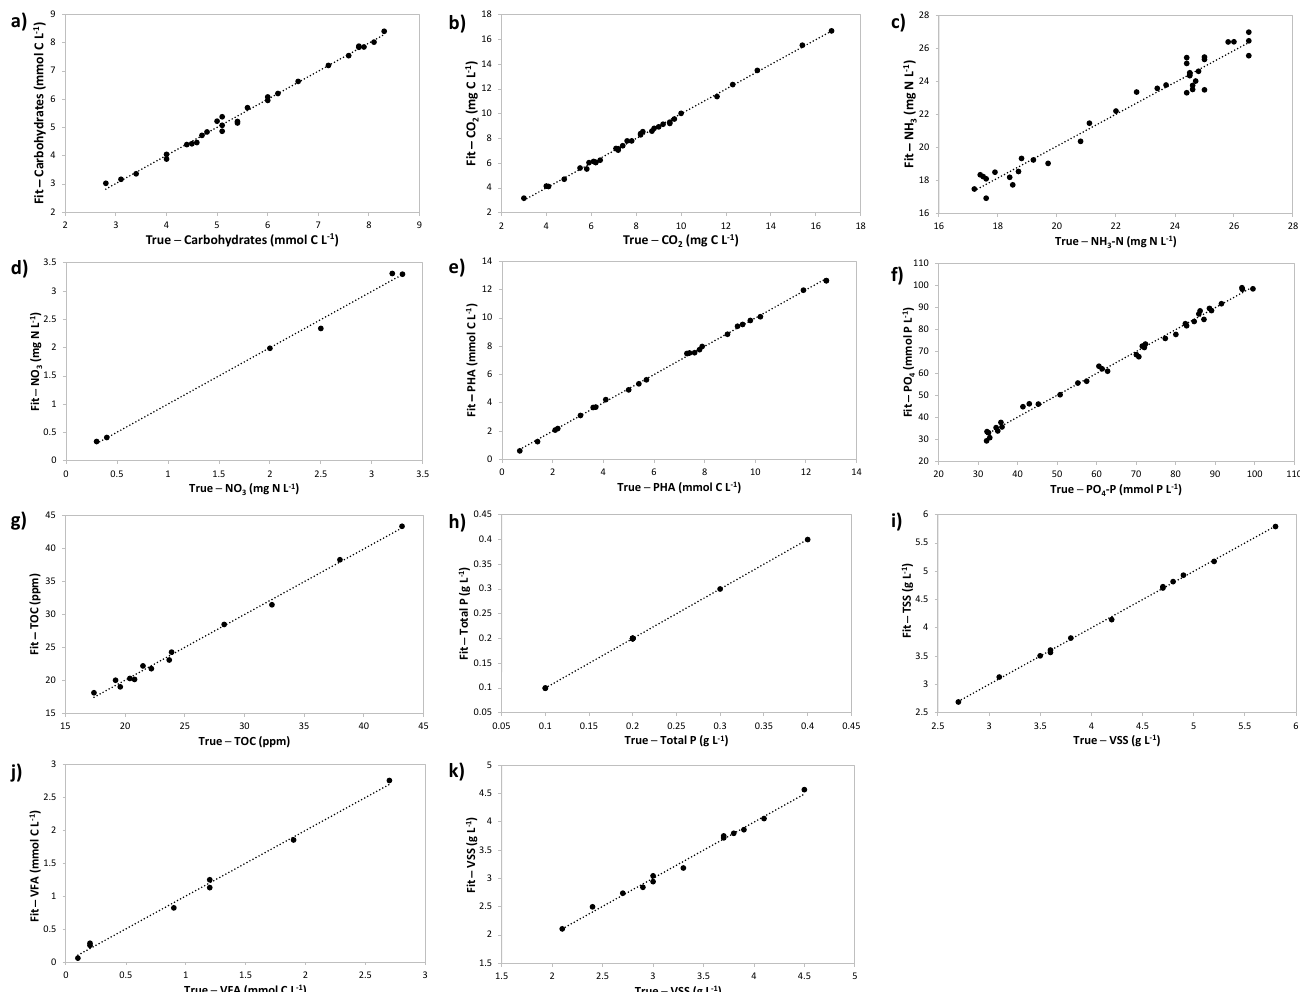
Figure 2. Representation of the Raman-PLS calibration models developed for ( a ) total carbohydrates; ( b ) carbon dioxide (CO 2 ); ( c ) ammonia (NH 3 ); ( d ) nitrate (NO 3 ); ( e ) polyhydroxyalkanoates (PHAs); ( f ) phosphate (PO 4 ); ( g ) total organic content (TOC); ( h ) total phosphorus (total P); ( i ) total suspended solids (TSSs); ( j ) volatile fatty acids (VFAs); and ( k ) volatile suspended solids (VSSs) along with the statistical calibration results.